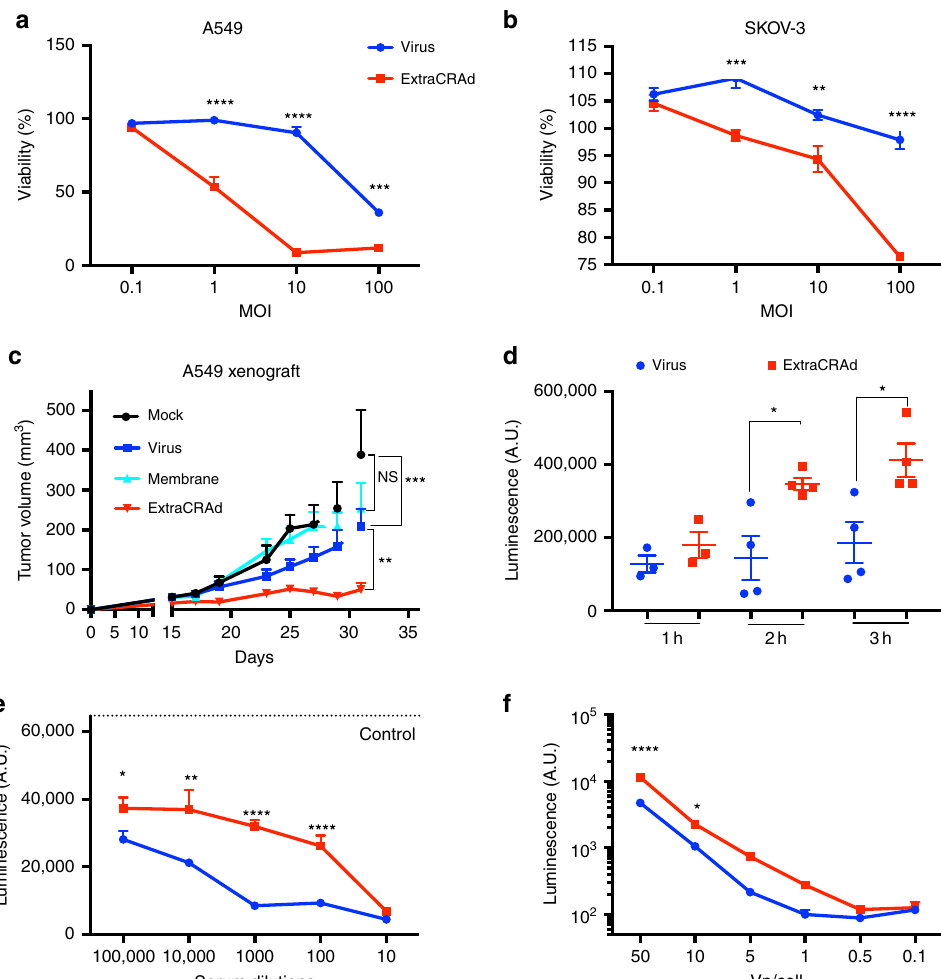
Fig. 3 ExtraCRAd mechanism of infectivity, transduction, and antibody resistance. Infectivity assay on a A549 (high-CAR) and b SKOV-3 (low-CAR) cell lines. Both the cell lines were infected with ExtraCRAd (red) or the naked virus (blue). Cell viability at 3 days was evaluated by the MTS assay. The data are presented as mean ± s.d. ( n = 3). c In vivo assessment of the oncolytic ef fi cacy of the naked virus compared to ExtraCRAd in A549 xenografts in nude mice. The mice were injected subcutaneously with 5 × 10 6 cells per fl ank. The treatments (mock, PBS; CCM, cell membrane vesicles derived from 3 × 10 6 A549 cells; Virus, 1 × 10 9 viral particles; ExtraCRAd, 1 × 10 9 viral particles co-extruded with 3 × 10 6 A549 cells) were injected at day 15 and at day 25 post tumor implantation. The data are presented as mean ± SEM ( n ≥ 8 ) and were analyzed by two-way ANOVA followed by Tukey ’ s post-test. Error bars represents SEM. The levels of statistical signi fi cance were set at probabilities ** p < 0.01 and *** p < 0.001. d Uptake kinetic study: the differences in the uptake kinetic were assessed by infecting A549 cells with ExtraCRAd or naked virus (adenovirus modi fi ed to express luciferase) for 1, 2, or 3 h, and by 24 h incubation to allow the expression of luciferase. The data are presented as mean ± s.d. ( n ≥ 3) with the dot plot of the single replicates. Unpaired t -test was used to assess statistical signi fi cance. Neutralizing antibodies assay performed with e plasma from pre-immunized mice and f with anti-adenovirus serotype 5 antibody. ExtraCRAd and the naked virus were pre-incubated with the serum of pre-immunized mice at different dilutions ( e ) or with